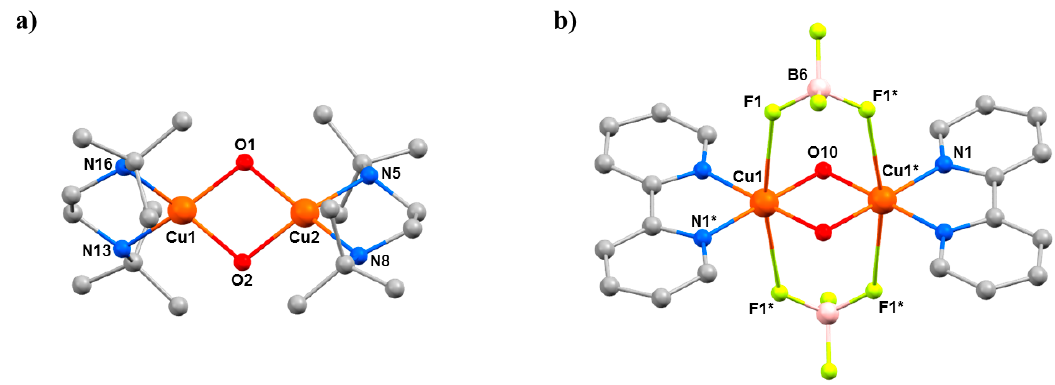
Figure 14. ( a ) The molecular structure of complex 10 at ambient pressure. ( b ) The molecular structure of complex 11 at ambient pressure. Colour code: Cu = orange, O = red, N = blue, C = grey, B = pink, F = pale green. H atoms (and counterions in ( a )) are omitted for clarity.